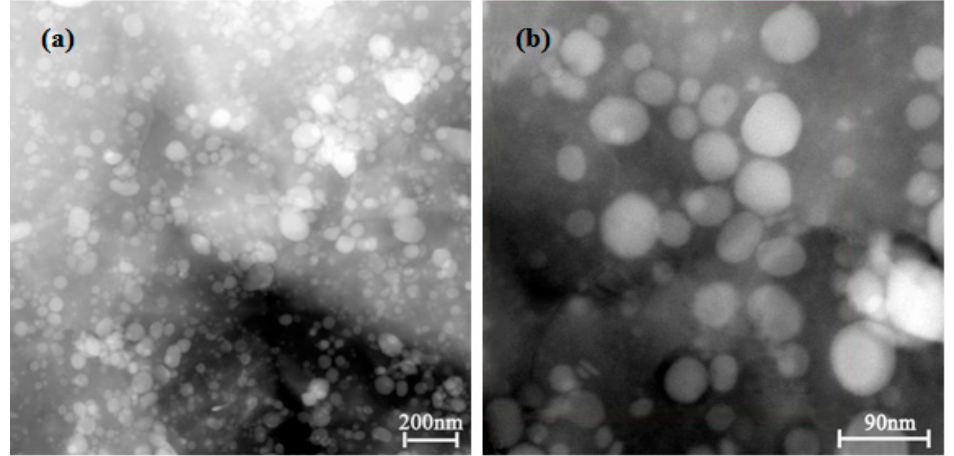
Figure 7. TEM images of the Cu-1.34Ni-1.02Co-0.61Si alloy after cold rolling at 47% reduction with the DCT in liquid nitrogen for 48 h: ( a ) microstructure of the matrix; ( b ) morphology and distribution of second phase.